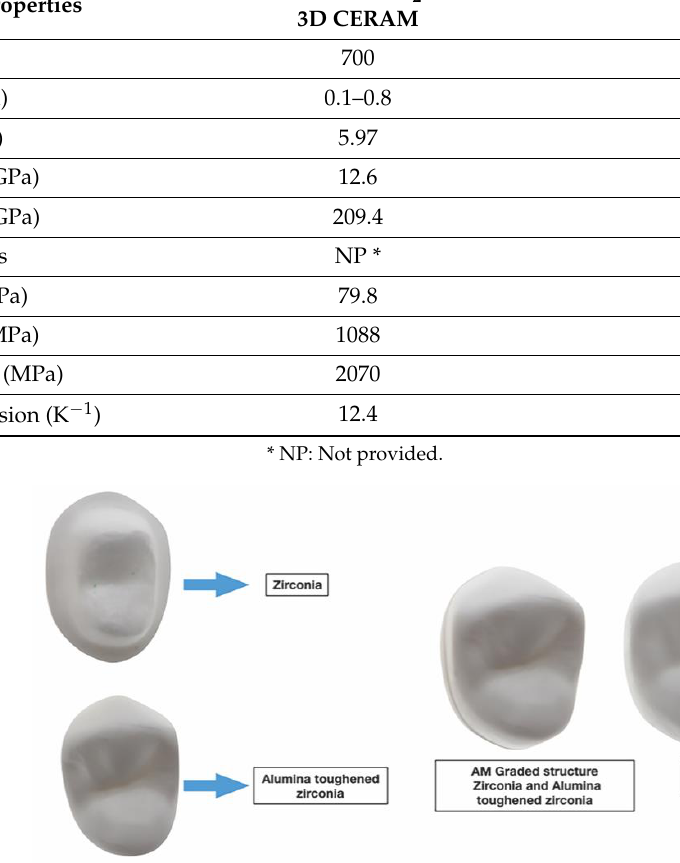
Figure 4. Additively manufactured Zirconia and bi-layered alumina reinforced zirconia.